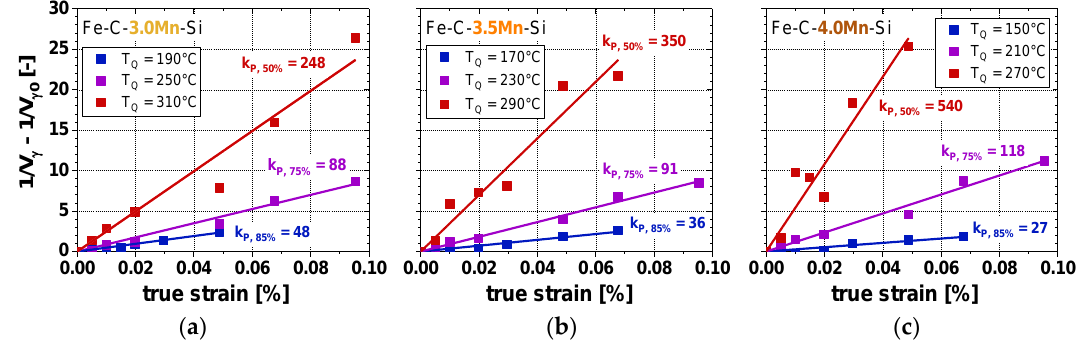
Figure 10. k P -values indicating the RA-stability of the ( a ) Fe-C-3.0Mn-Si, ( b ) Fe-C-3.5Mn-Si and ( c ) Fe-C-4.0Mn-Si steels quenched to different T Q in order to adjust 50 vol.% (blue), 75 vol.% (purple), and 85 vol.% (red) α ’ prim .